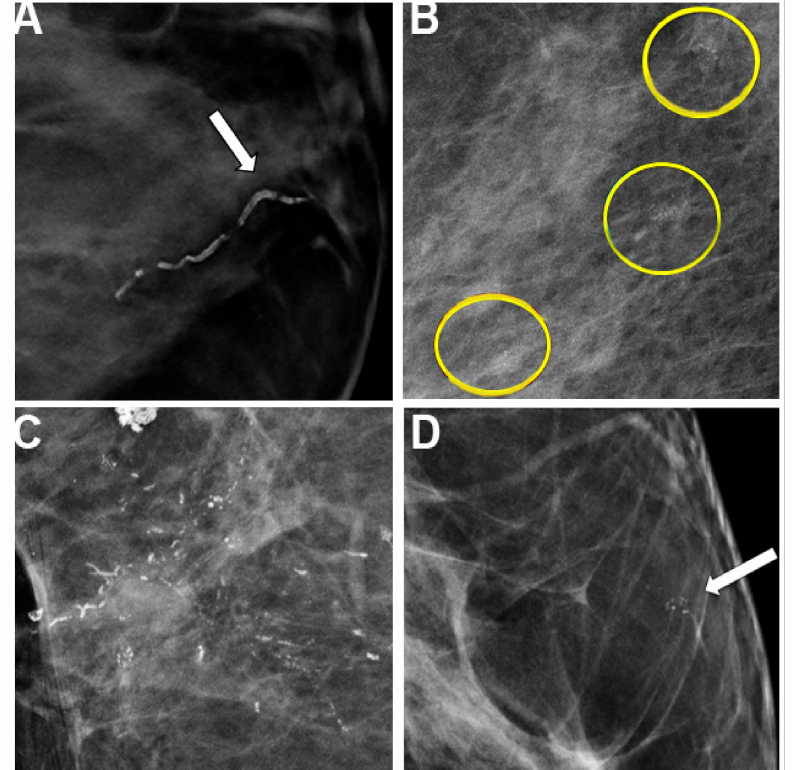
Figure 3. Mammography images depicting different appearances of calcifications. ( A ) Classic appearance of breast arterial calcifications (BAC) (white arrow) that are easy to discriminate and associated with diabetes. ( B ) Groups of microcalcifications (yellow circles) in a woman with ductal carcinoma in situ (DCIS) is shown in its most typical appearance on digital breast tomosynthesis (DBT). ( C ) A patient with DCIS with mammographic findings showing segmental fine pleomorphic and fine-linear branching calcifications. ( D ) A skin calcification resembles microcalcifications (white arrow) and often requires alternative views to localize to the skin. Any or all of these findings can be seen in a single mammogram and can create a convoluted picture for radiologists. (Adapted from